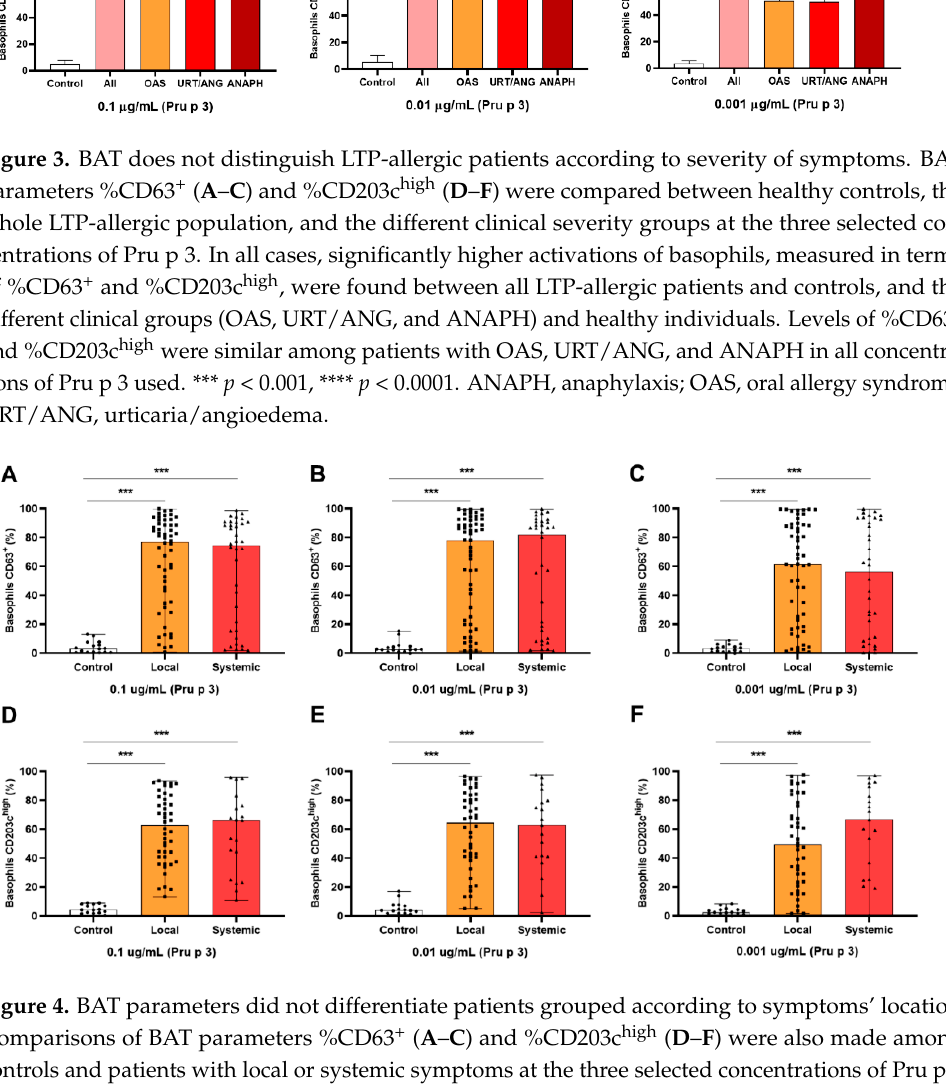
Figure 4. BAT parameters did not differentiate patients grouped according to symptoms’ location. Comparisons of BAT parameters %CD63 + ( A – C ) and %CD203c high ( D – F ) were also made among controls and patients with local or systemic symptoms at the three selected concentrations of Pru p 3 (0.1, 0.01, and 0.001 μ g/mL). BAT parameters %CD63 + and %CD203c high were significantly higher between patients with local or systemic symptoms in comparison to healthy controls. However, no changes were found in basophil activation between LTP-allergic individuals with local or systemic reactions. *** p <